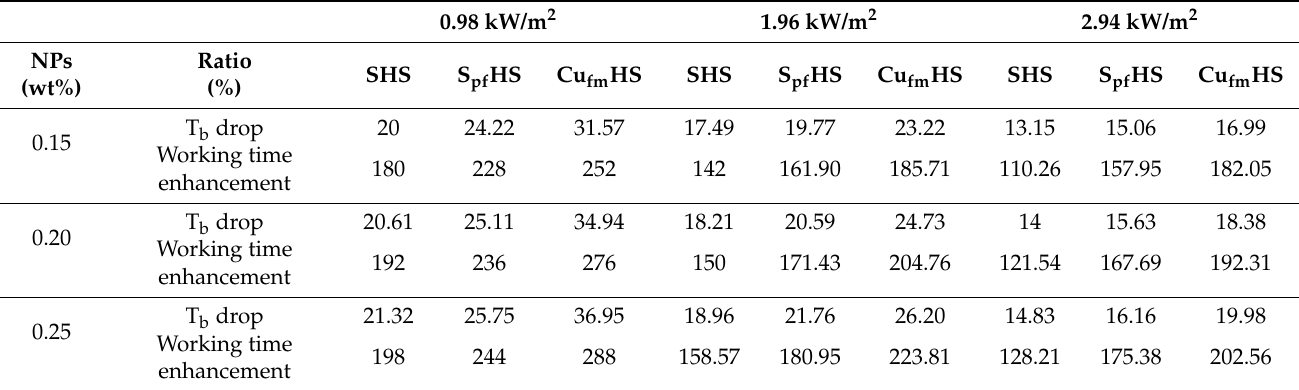
Table 6. Comparison of the T b drop ratio and working time improvement